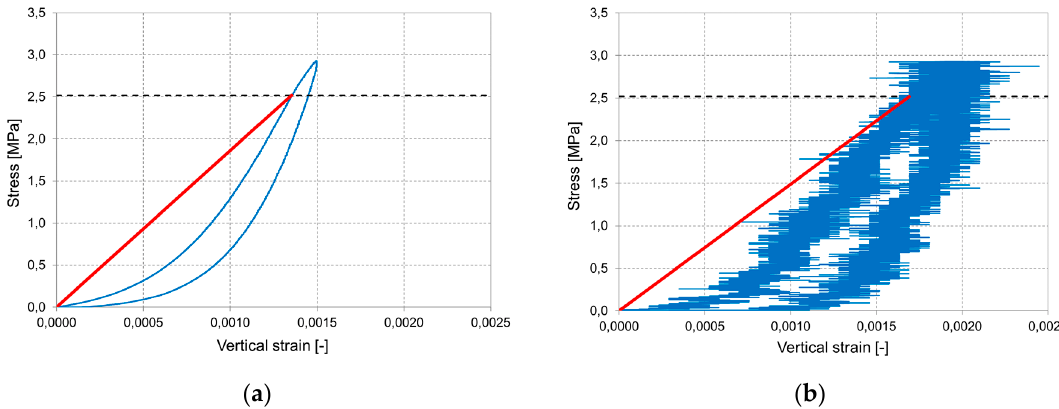
Figure 13. Stress versus strain curve for the masonry specimen, id M0M10, obtained by ( a ) contact dimensional measurements; ( b ) optical dimensional measurements.